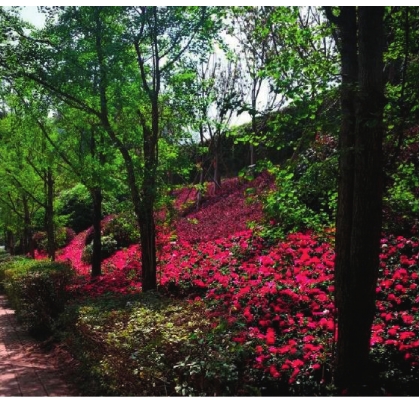
Figure 9: Practical application of joint ecological